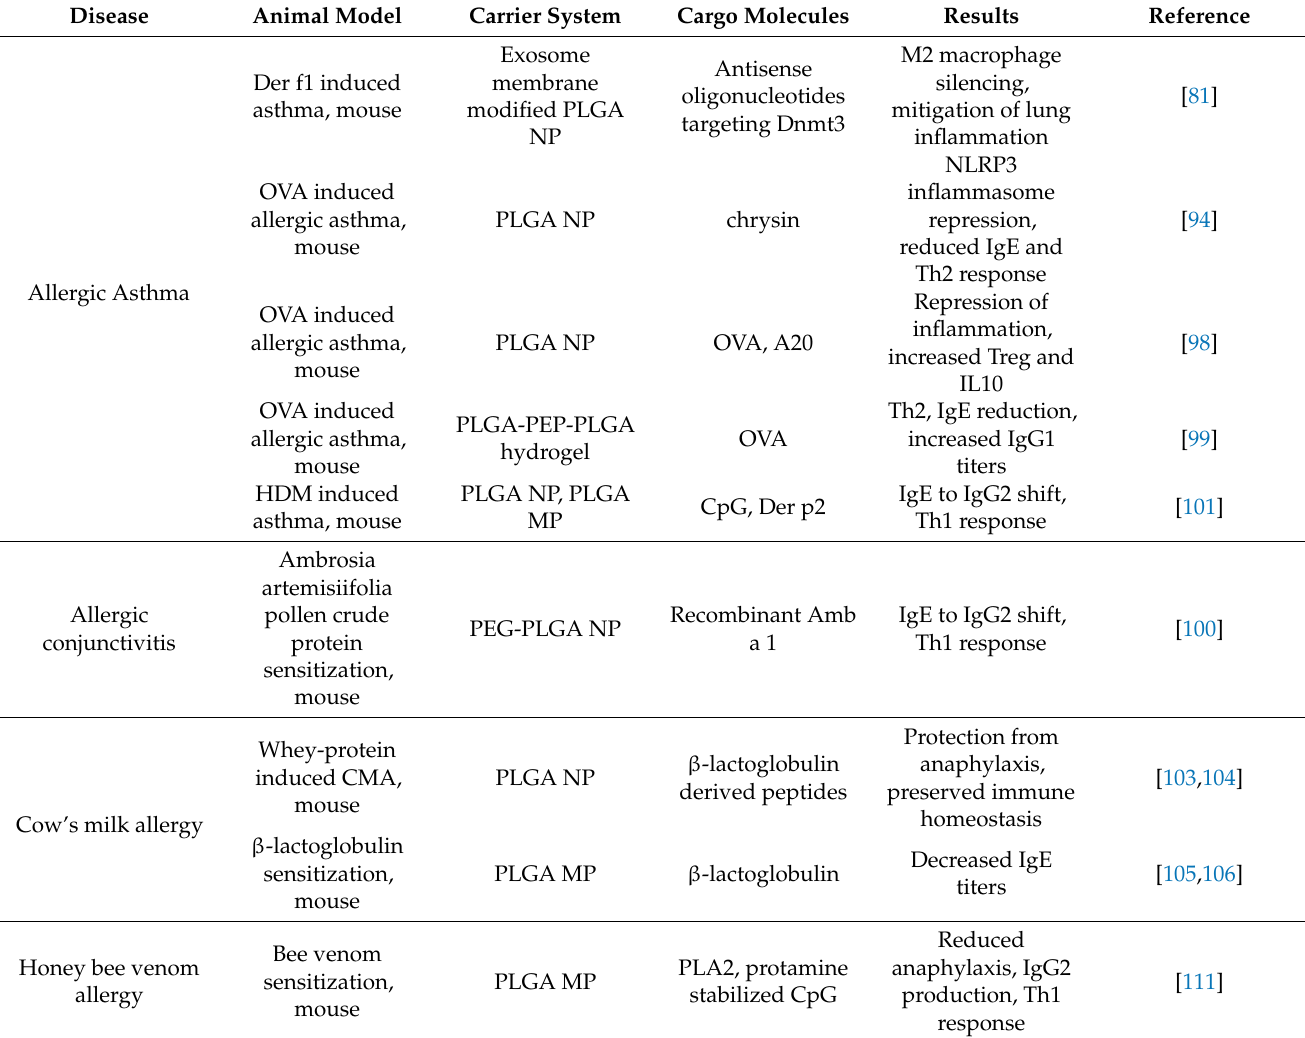
Table 2. Summary of PLGA mediated immunotherapy of allergic